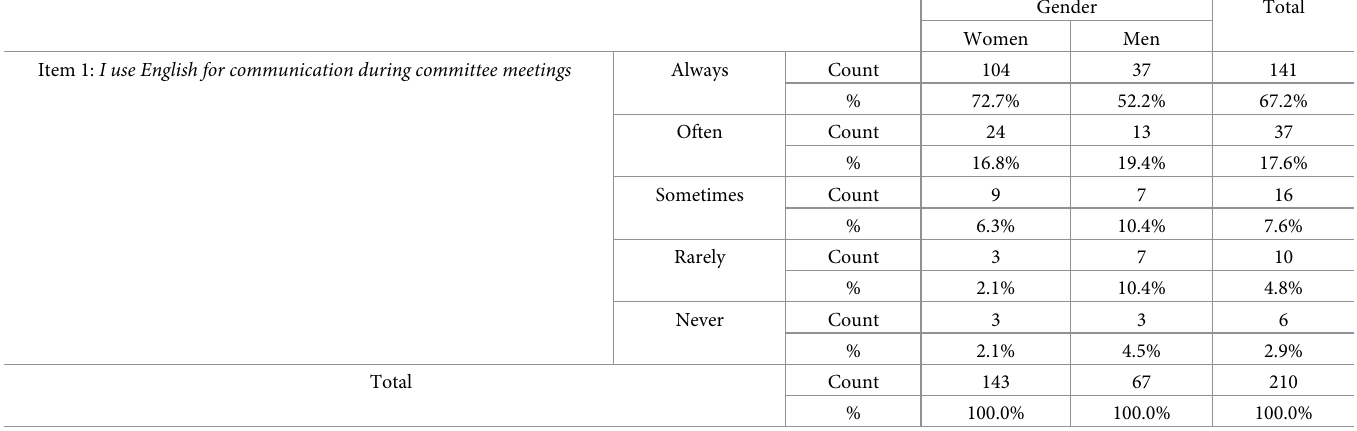
Table 1. Use of English during committee